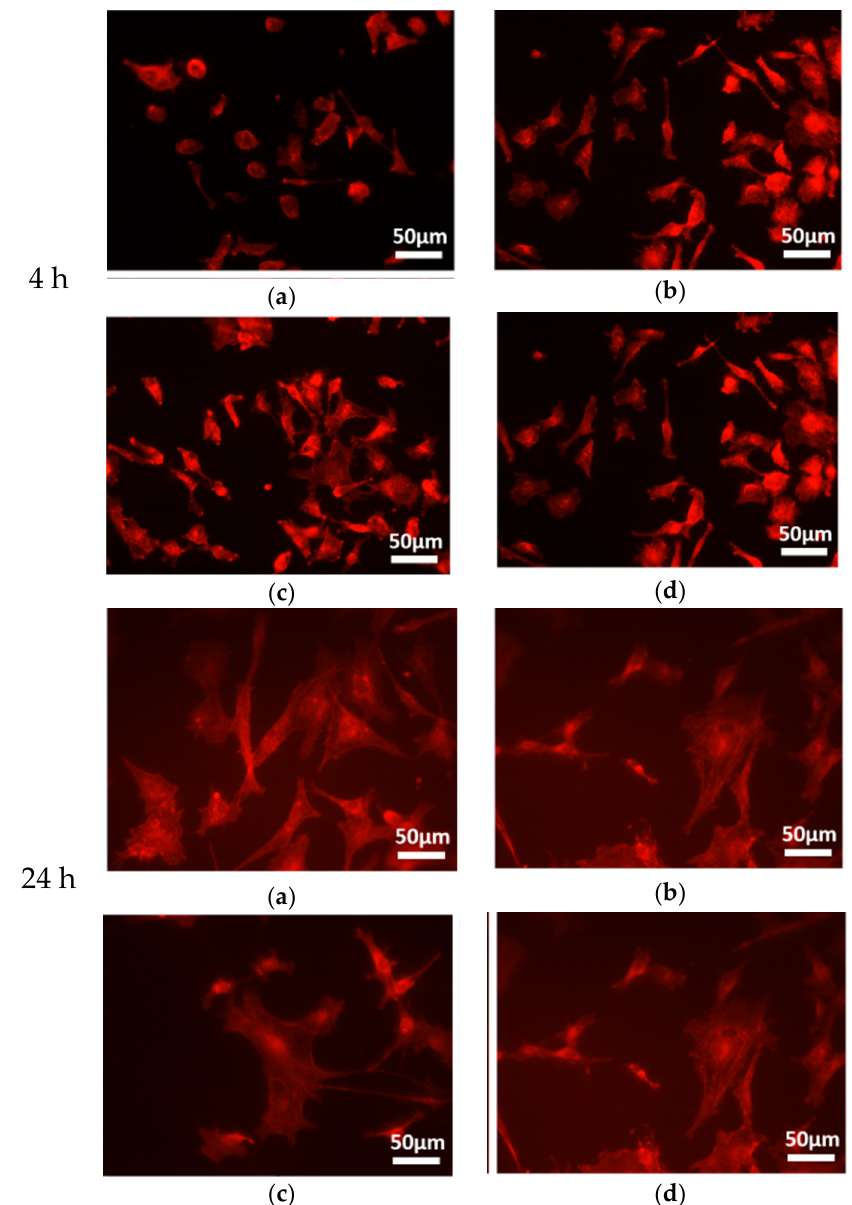
Figure 10. The images of fluorescence microscope under a 20× field of vision at 1, 4, and 24 h of incubation: ( a ) SLA sample; ( b ) SLA/NaOH-10s sample; ( c ) SLA-PECVD/NaOH-10s sample; and ( d ) SLA-PECVD/NaOH-10d sample.